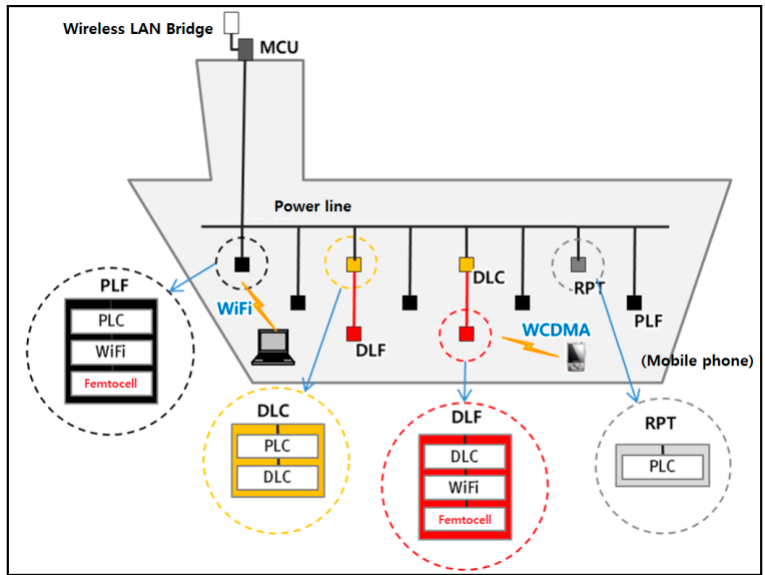
Figure 8. Detailed network configuration.